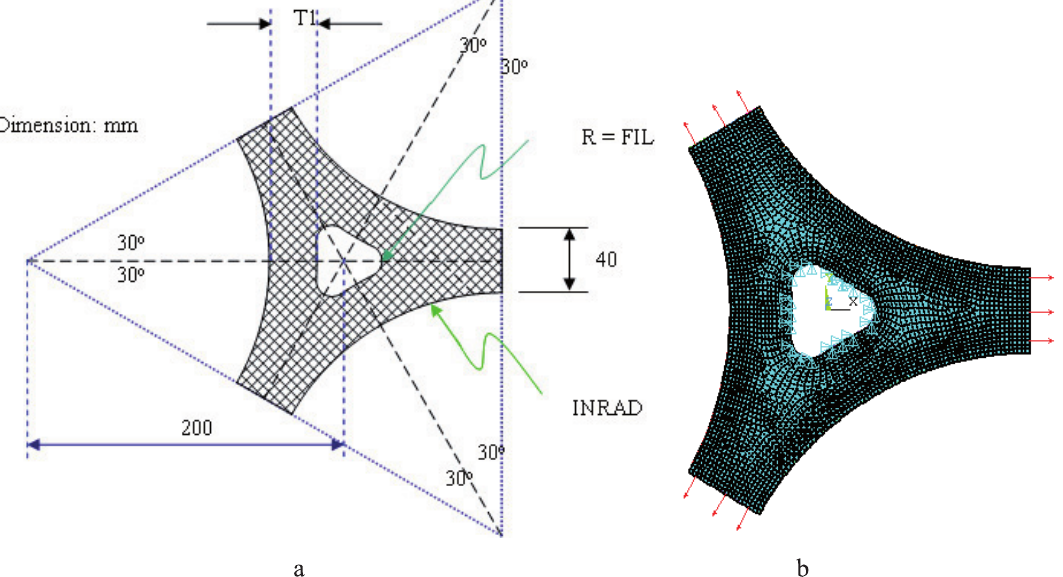
Fig. 7. (a) Geometry model and (b) Boudary conditions of triangular plate structure.